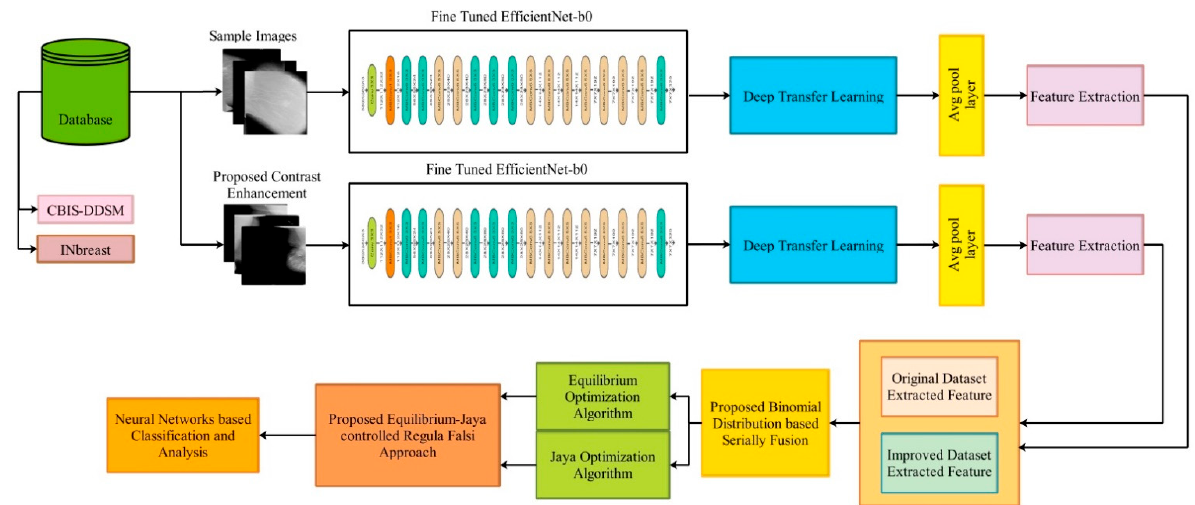
Figure 1. The proposed framework of an optimal deep learning feature fusion of the classification of breast cancer .